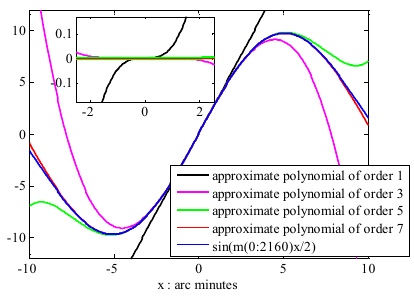
Figure 3. Approximation of sin( m Δ λ /2) as Δ λ = − 5 ′ ~5 ′ and m = 0~2160.